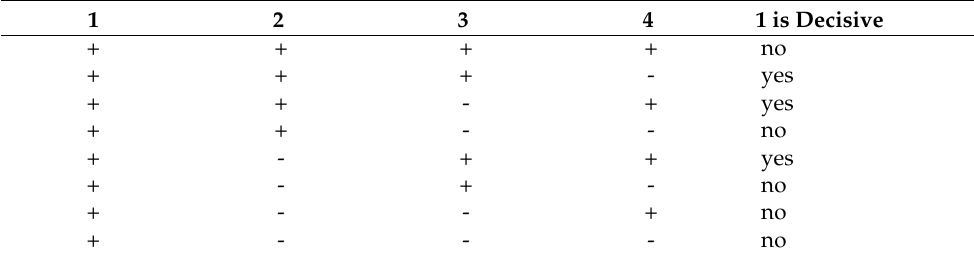
Table 1. Decisiveness of player 1 in game v . 1 2 3